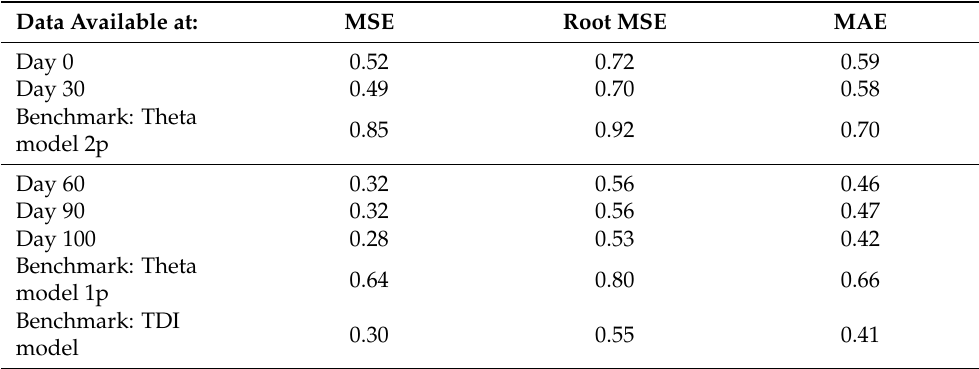
Table A4. Mean squared and absolute out-of-sample forecast errors of the median of Models (1) to (6) conditioned with available data over the current quarter after last-error correction (sub-sample